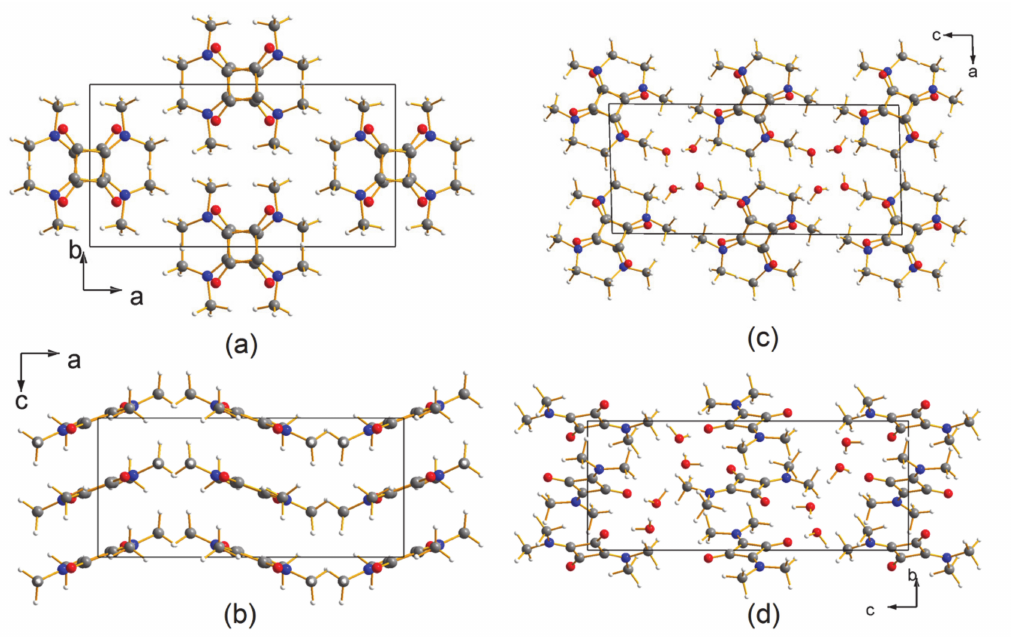
Figure 3. ( a ) Crystal packing of SQ at T = 18(1) K, as seen along the c axis. The atoms have the usual color code; grey: C; white: H; red: O; blue: N). ( b ) Same as ( a ), along b . ( c ) Crystal packing of SQDH at T = 20(1) K viewed down the b axis. ( d ) Same as ( c ), along a